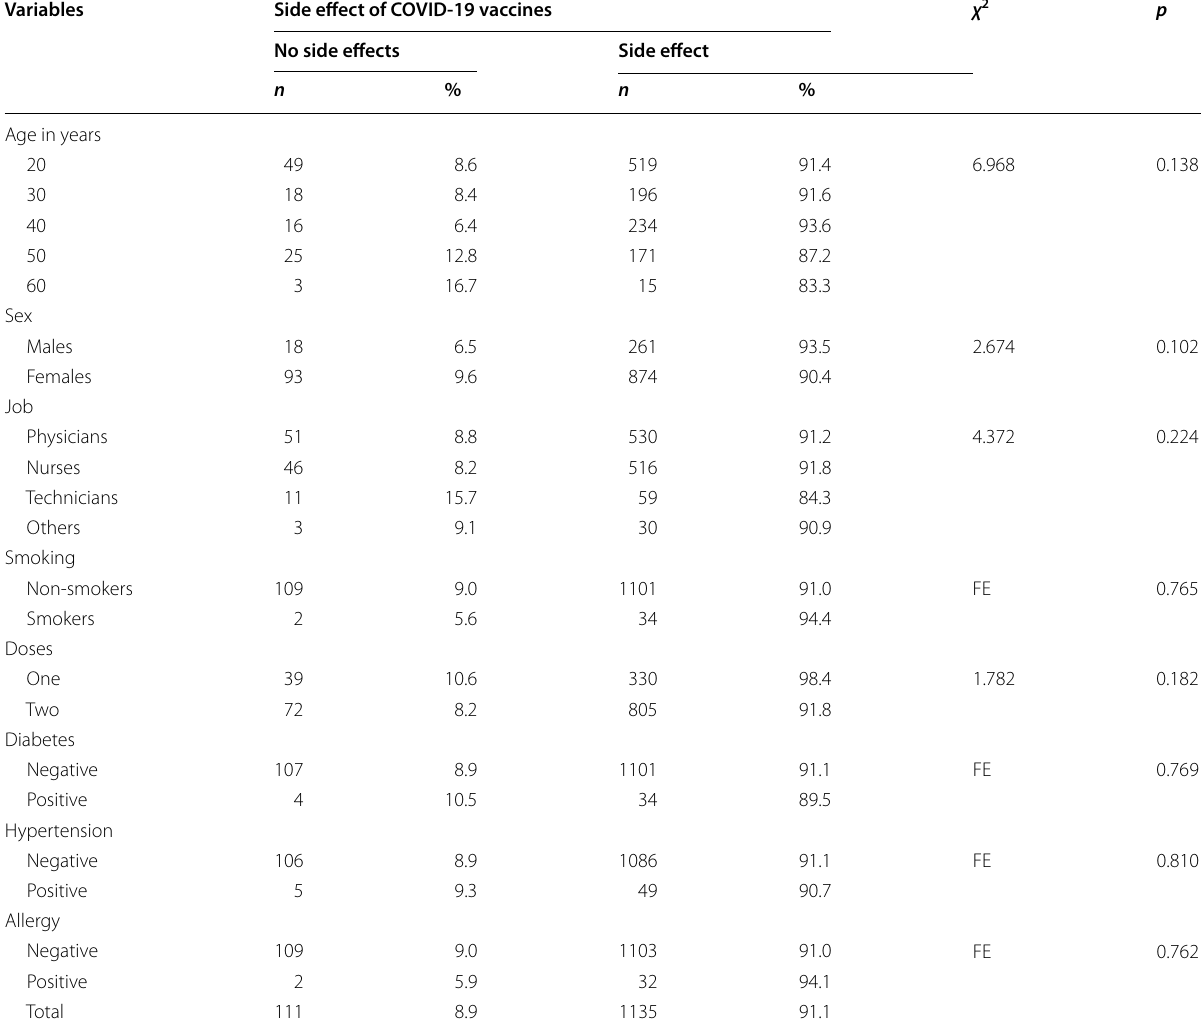
Table 5 Potential factors associated with COVID-19 vaccine side effects